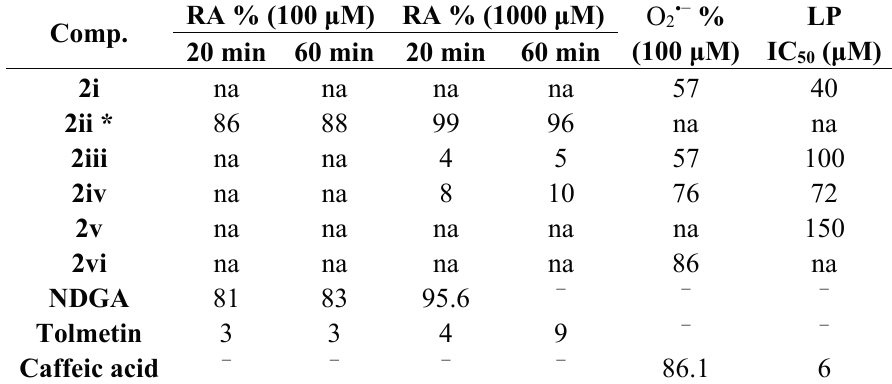
Table 6. Reducing ability measured as interaction with DPPH (RA %); superoxide radical scavenging activity (O 2• − %); inhibition of heme-dependent lipid peroxidation of linoleic acid (LP, IC 50